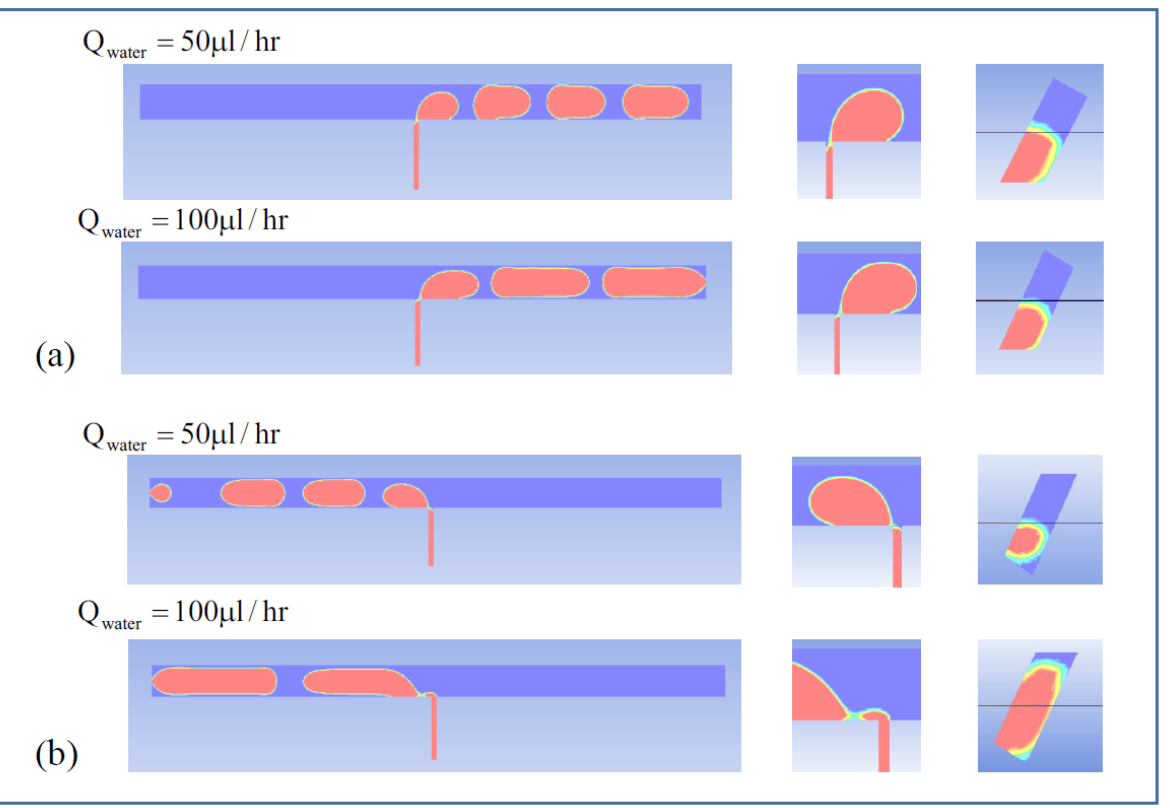
Figure 7. Void fraction of micro-droplet phase in the channel of W12-A36-B45. ( a ) A → B direction, ( b ) B → A direction.